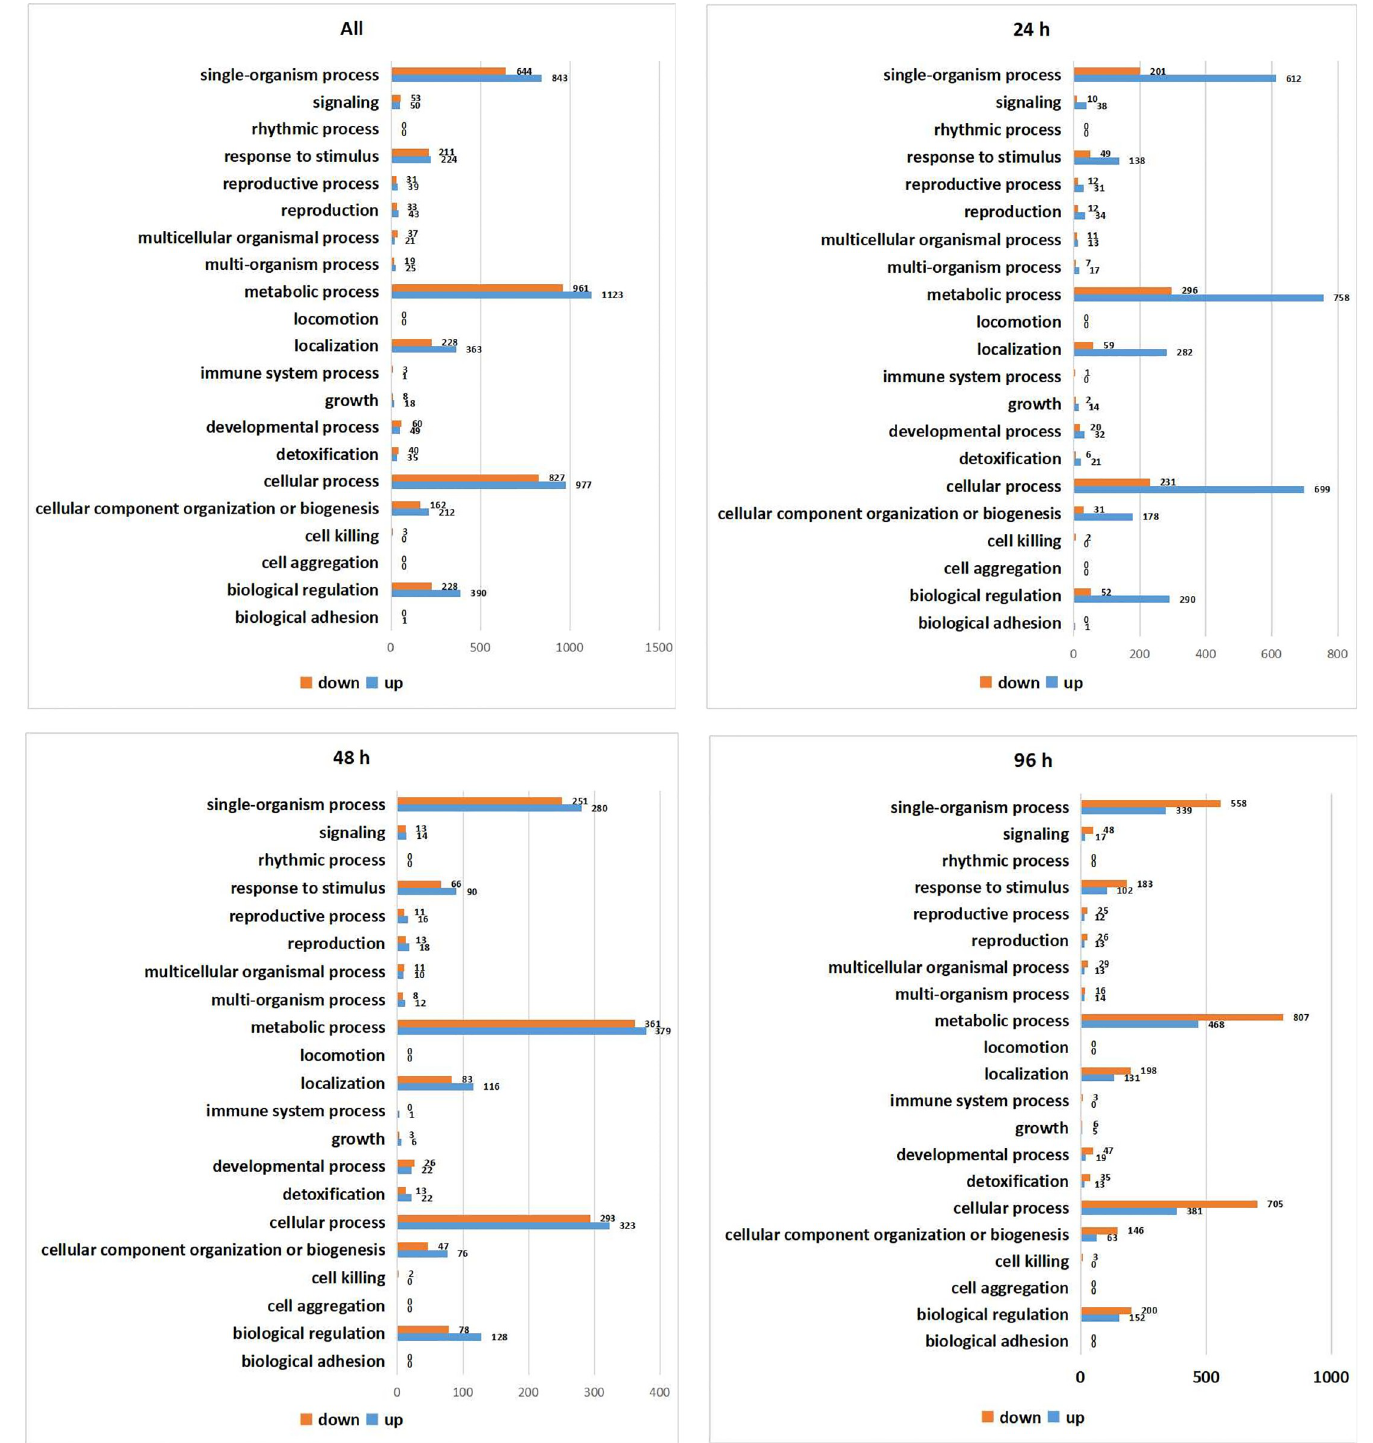
Fig 4. Plots of gene ontology (GO) terms derived from the biological process category of the genes. (a) DEGs in total. (b) DEGs under drought treatment for 24 h (compared to the control). (c) DEGs under drought treatment for 48 h (compared to the control). (d) DEGs under drought treatment for 96 h (compared to the